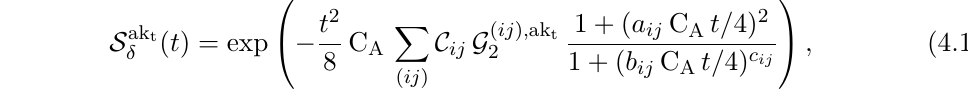
combination is large for all values of R in the gluon channel. This signifies the importance of the contributions of NGLs and CLs in our distribution for all values of R , as apposed to the jet mass observable where the combined NGLs and CLs are significant only for small values of R , and tend to cancel each other out at larger values of R for both channels